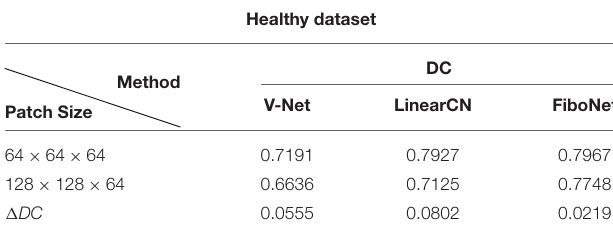
TABLE 5 | Results using different size of training